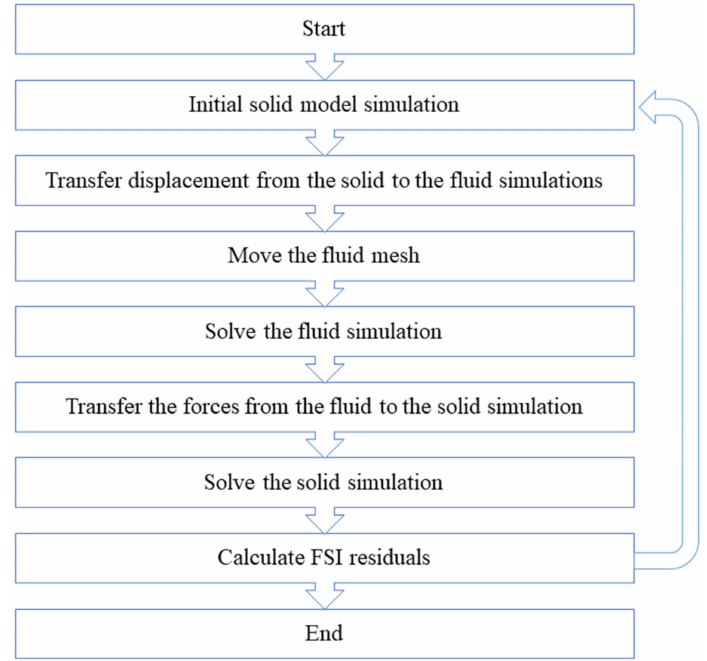
Figure 1. Scheme of FSI